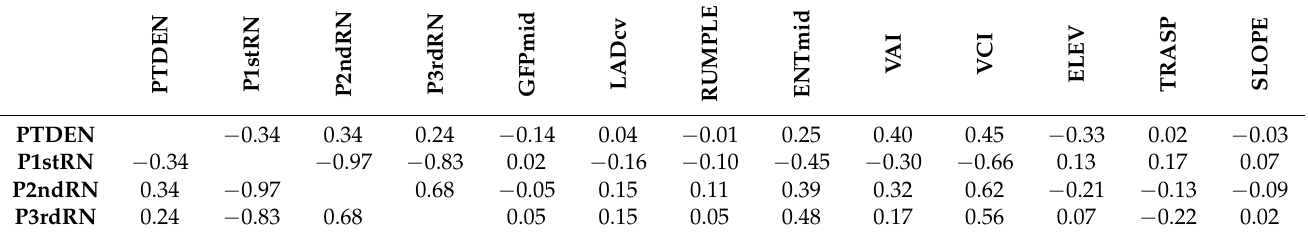
Table A2. Pearson’s correlations among predictor variables. A correlation table showing all pairwise Pearson’s ( r ) correlation scores across the 13 predictor variables used for modeling snag classifications. A list of the predictor variable descriptions can be found in Table 2. Scores with an absolute value of r ≥ 0.9 were considered “strongly correlated” and are highlighted in grey. Positive scores suggest a relationship where a pair changes value in the same direction, while negative scores indicate a relationship where a pair changes value in opposite